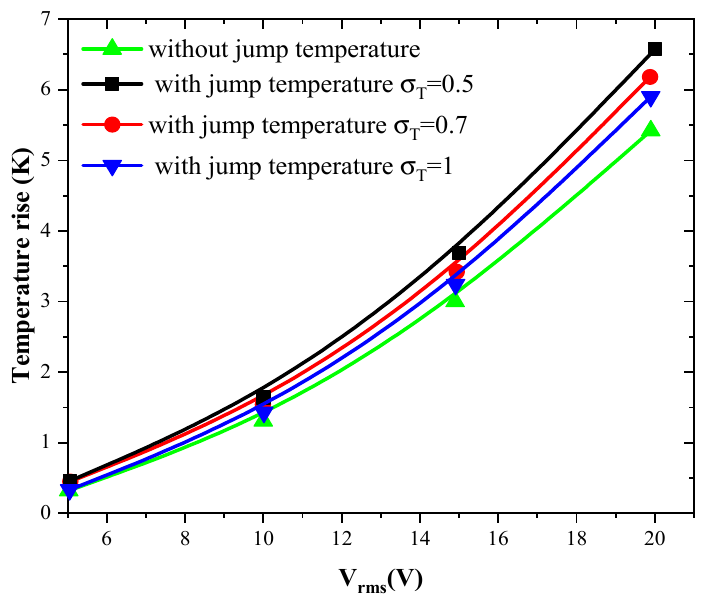
Figure 6. Temperature rise versus the applied voltage for second structure and for Kn = 0.02. Three values of thermal accommodation coefficient, σ T = 0.5, 0.7, and 1 are tested.